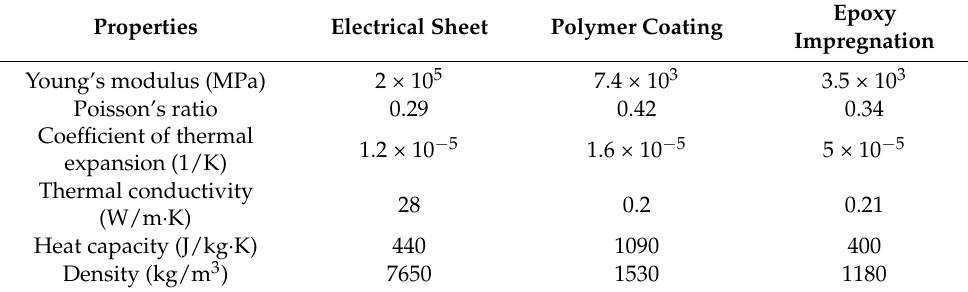
Table 2. Relevant material properties of the motor